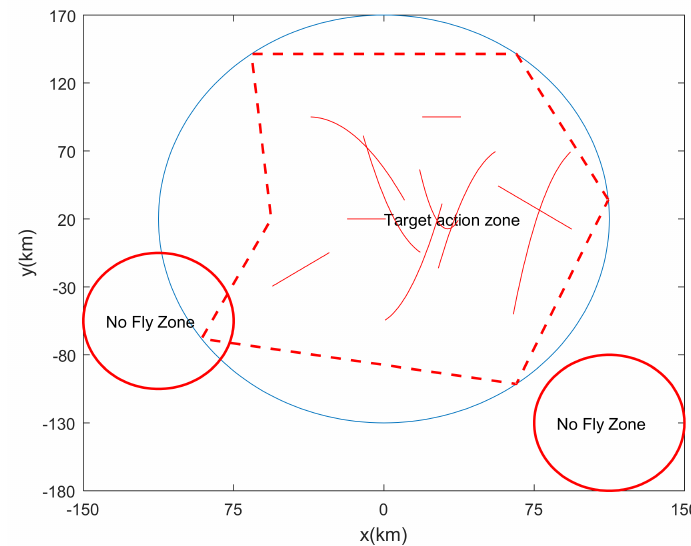
Figure 9. Target action zone and no fly zone.